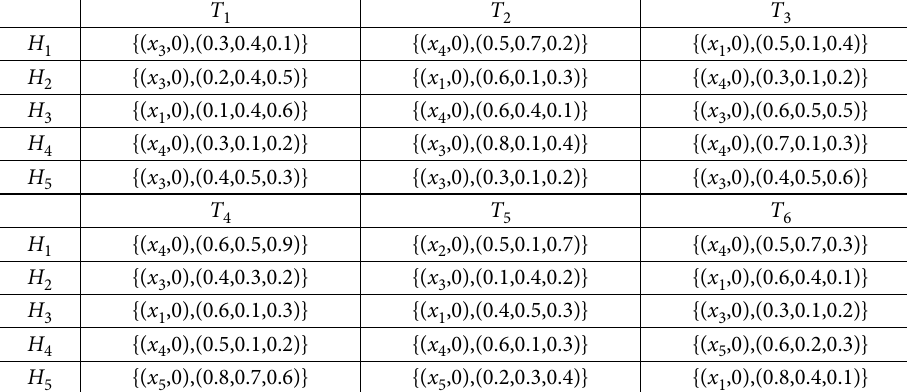
Table 2. Evaluation matri x by W 2